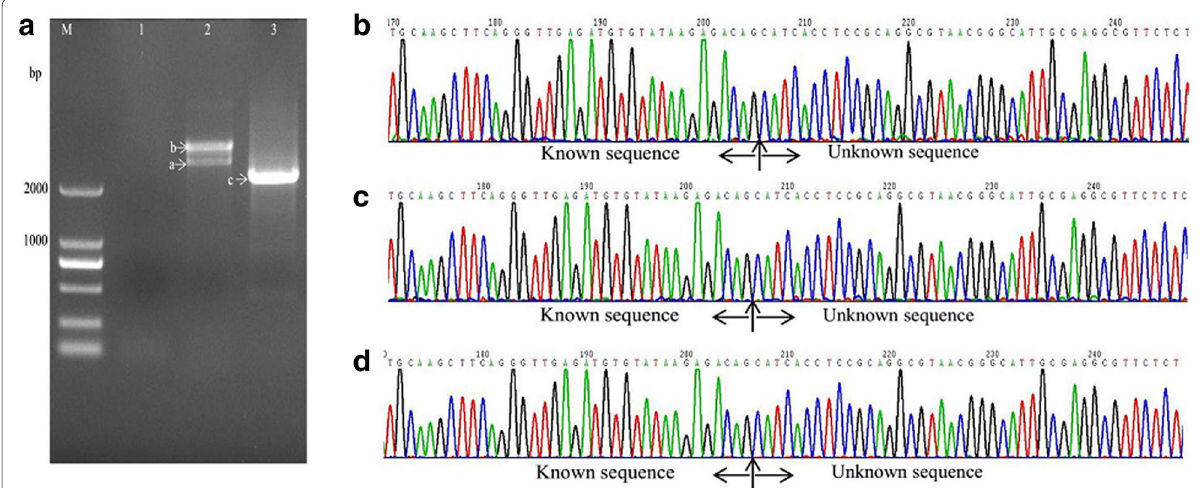
Fig. 2 Amplification and sequencing results of the sequence flanking the Tn5 insertion site of sample 1. a Amplification products shown on an agarose gel. Lanes 1–3 show the results of steps 1–3, respectively. b Chromatograms of DNA in band a. c Chromatograms of DNA in band b. d